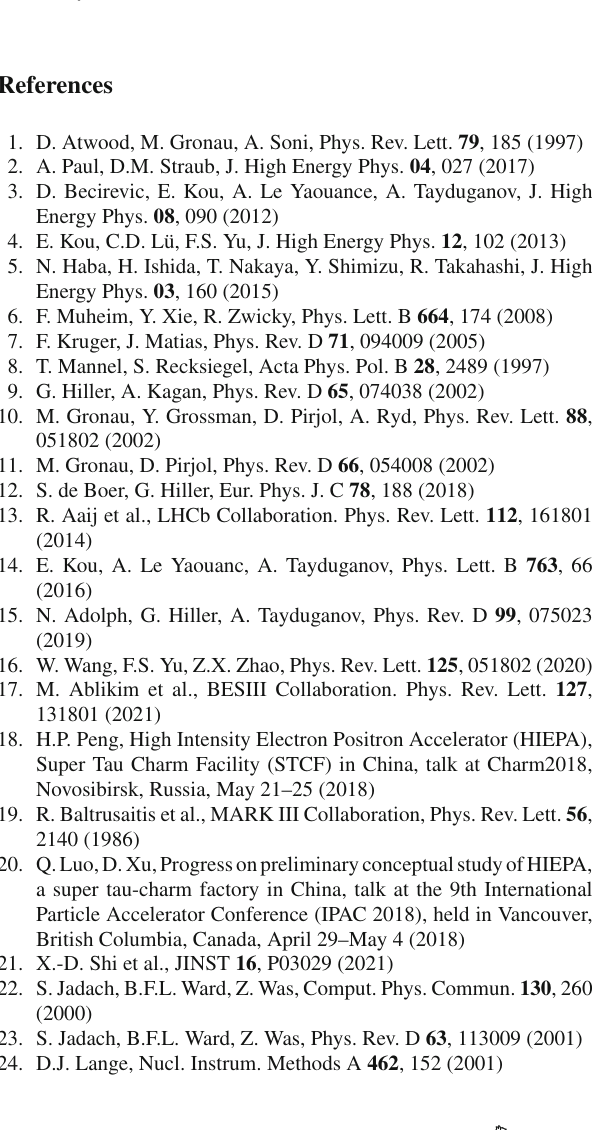
corresponding UD